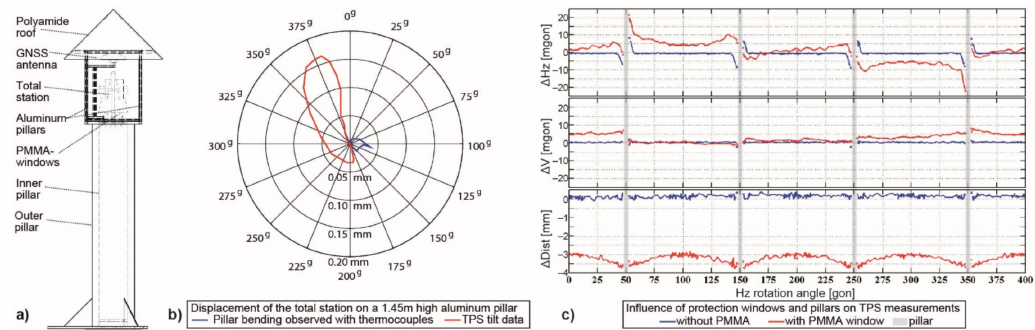
Figure 3. Special aspects of the total station monitoring setup for high-precision measurements. ( a ) Double-walled and independently grouted pillar and protection house for the total station; ( b ) position deviation on the top of the inner aluminum pillar (where the RTS instrument is located) from tilt measurements of August 30 2015 (red) and contribution of the pillar bending as estimated from thermocouple measurements on the pillar itself (blue; modified from Frukacz et al., 2017); ( c ) variation of RTS measurements as function of angle between line of sight and pillar (framework) with four different PMMA windows (red) and without windows (blue); note that every 100 ◦ gon (=90 ◦ degree) there is a cubic aluminum rod of 20 mm width (modified from Wieser and Presl,